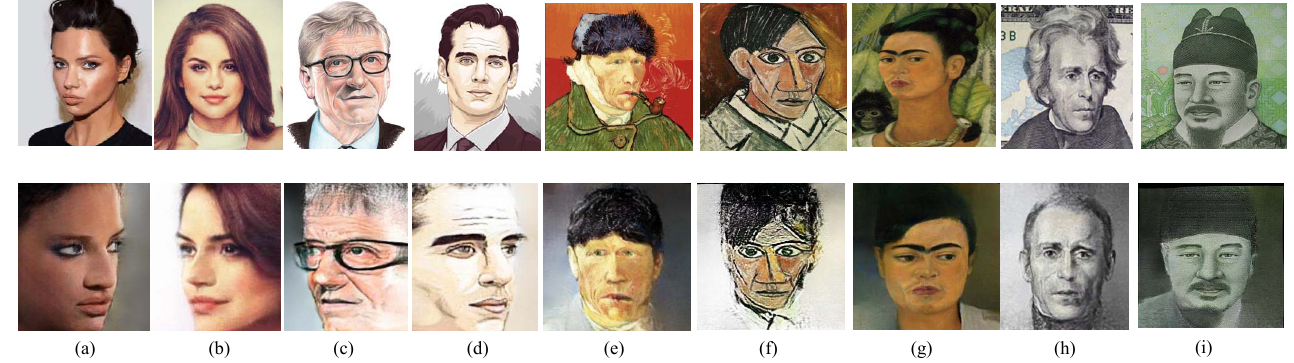
Figure 1. Teaser images. Portraits in upper row are rotated in lower row. ( a , b ) Photorealistic oil paint portraits. ( c , d ) Watercolor portraits. ( e – g ) Famous artistic portraits from Gogh, Picasso and Kahlo, respectively. ( h , i ) Banknote portraits. We rotated them to the right for ( a , d ), the left for ( b , c ) and the front angle for ( e – i